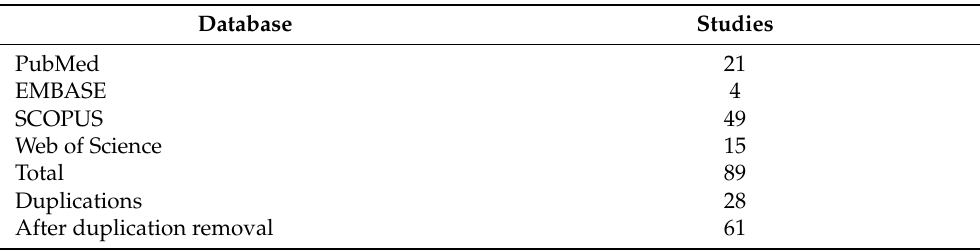
Table A1. Results of the search